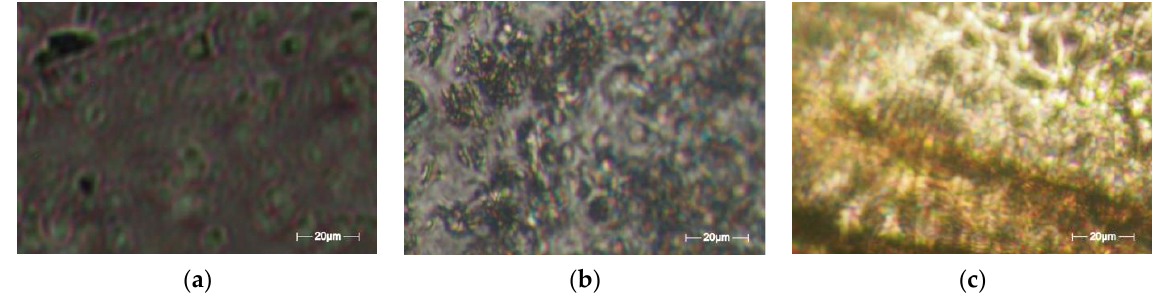
Figure 6. Representative POM images [17] of the formulations ( a ) U 1 ; ( b ) U 2 ; ( c ) U 4 . The scale bar for the POM photographic images (from Figure 6: (a) U 1 ; (b) U 2 ;